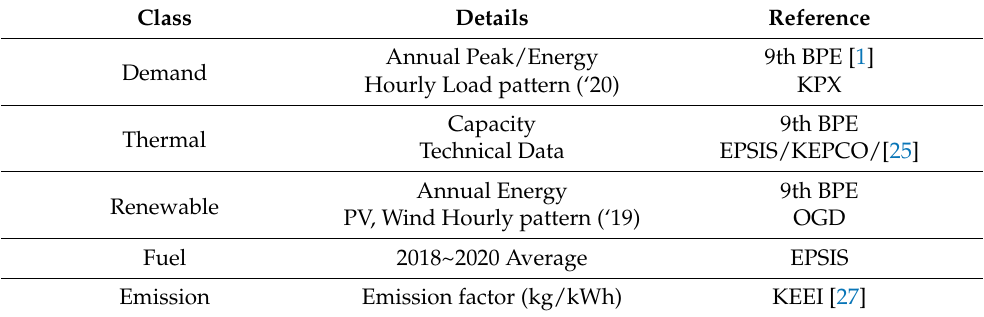
Table 1. Simulation input